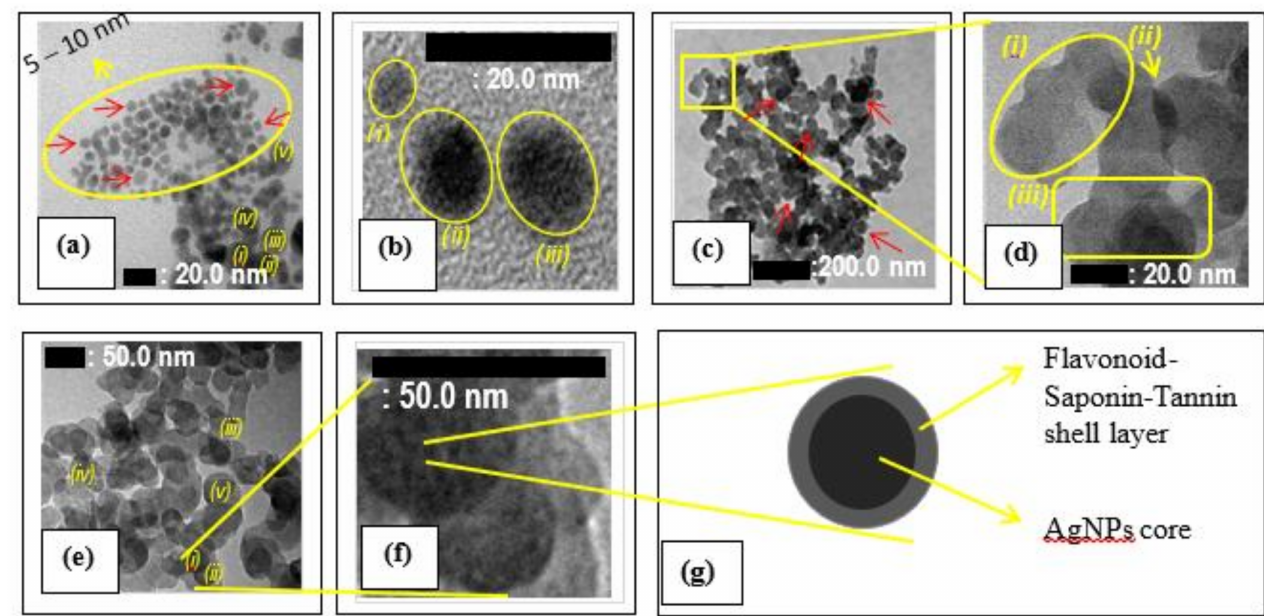
Figure 2. ( a , b ) TEM images of AgNPs; ( c , d ) TEM image s of ACNPs; and ( e , f ) TEM images of AgNPs-immobilized ACNPs; ( g ) Schematic illustration of 5–10 nm AgNPs@Flovonoid-Saponin-Tannin core-shell nanostructures immobilized on the surface of 50 nm ACNPs. Here, the particles images marked (i) , (ii) , (iii) , (iv) , and (v) are randomly selected particles to determined the average size of the associated